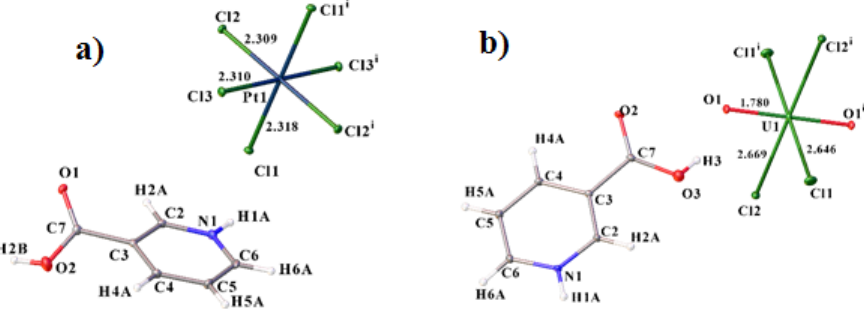
Figure 1. Molecular structure of I ( a ) and II ( b ) at 100 K, including atom labeling. Only one position of the disordered H-atom of the carboxyl group is shown in I . Displacement ellipsoids are drawn at the 50% probability level. Table 2. Selected geometric parameters (Å, °) for I .